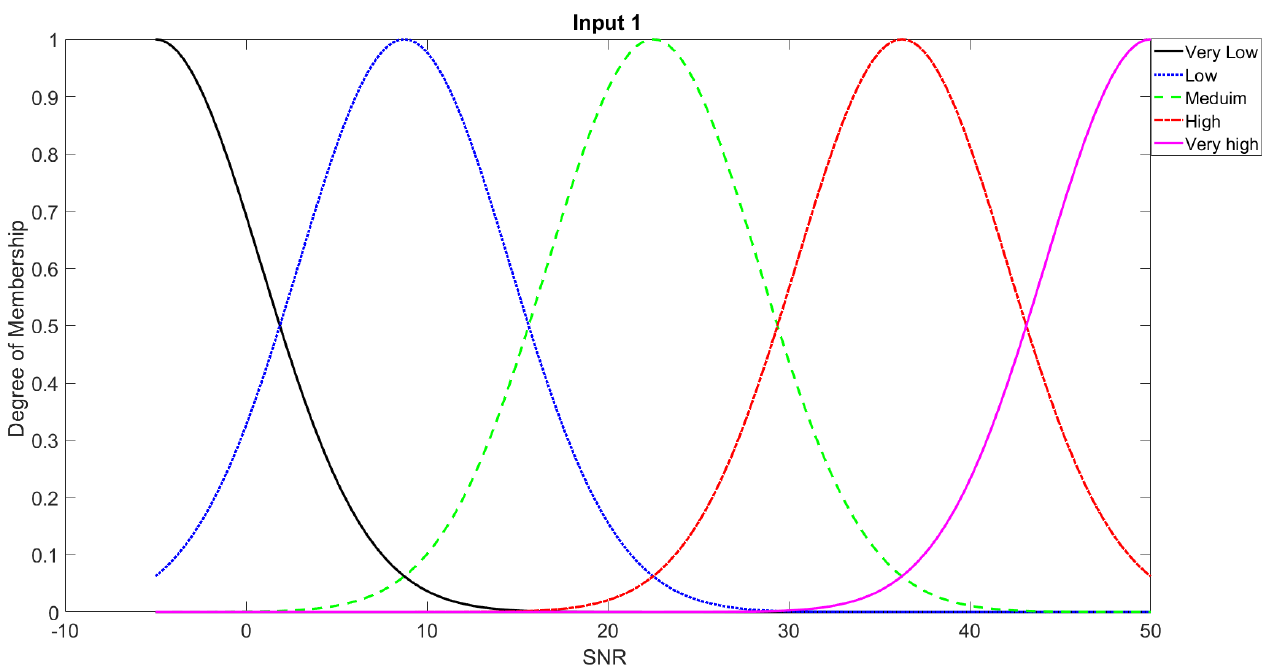
Figure 8. Fuzzy membership function for SNR input.